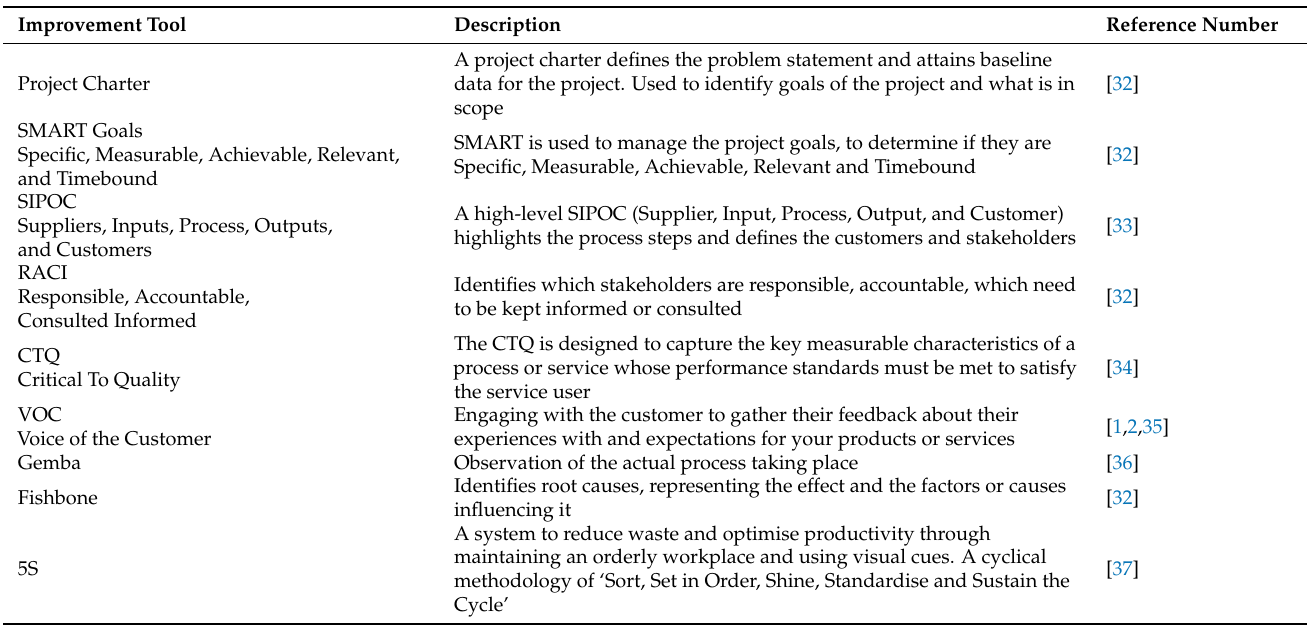
Table 1. LSS tools used by the